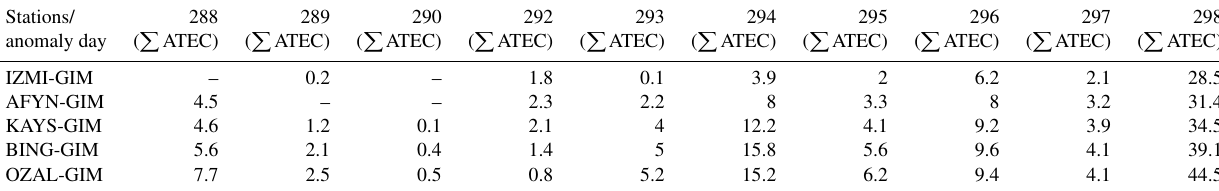
Table 7. Total amount of anomaly in TECU for analyzed